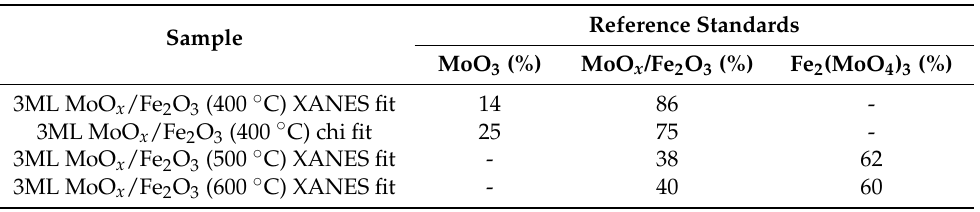
Table 1. XANES LCF fittings for 3ML MoO x /Fe 2 O 3 . Fittings were performed using the initial dried